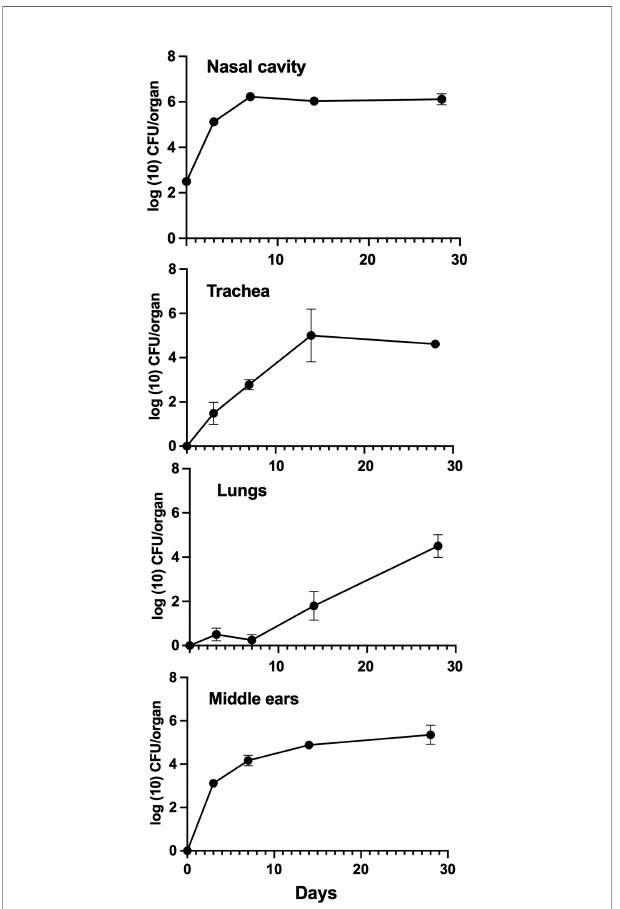
FIGURE 2 | Growth of B . bronchiseptica in Rag-1 − / − mice. Graphs represent the number of B . bronchiseptica RB50 CFU recovered from the nasal cavity, trachea, lungs, and middle ears of groups of Rag-1 − / − mice over time following inoculation. Error bars represent the standard deviation ( n =